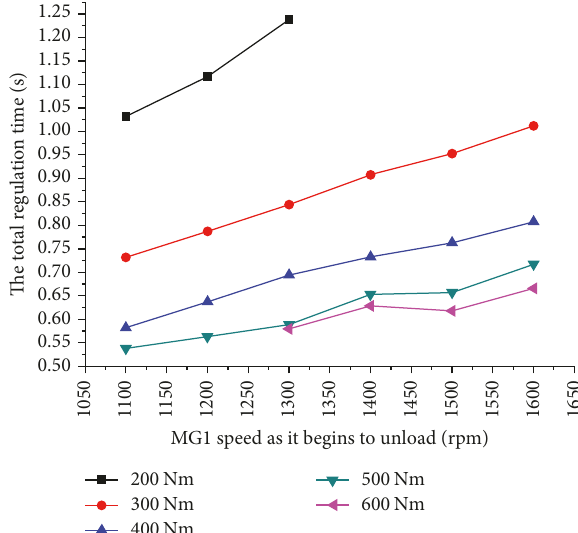
Figure 11: The curves of 𝜔 raw MG 1 and 𝑡 MG 1 under different 𝑇 𝑇 MG 1 .